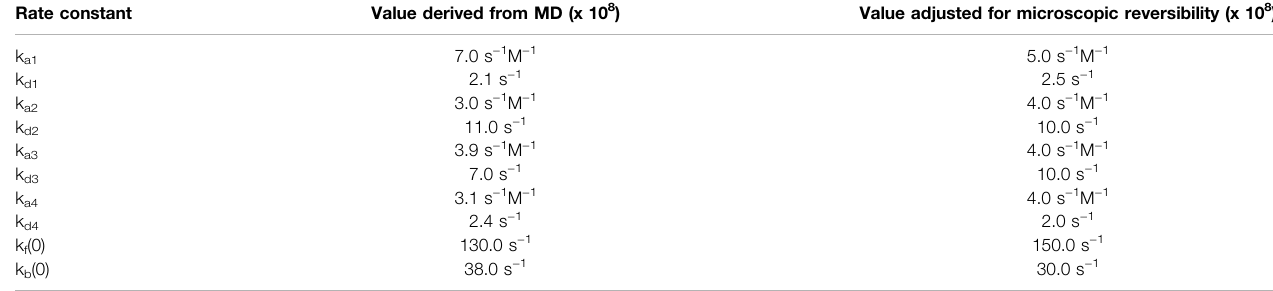
TABLE 1 | Rate constants evaluated from MD and adjusted by microscopic reversibility. Rate